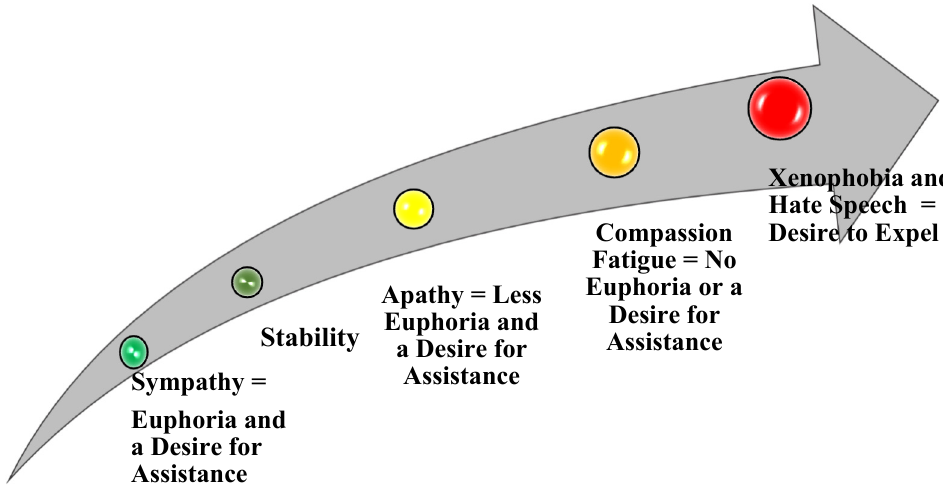
Figure 1. Stages of forming xenophobia against Syrian refugees on social media.